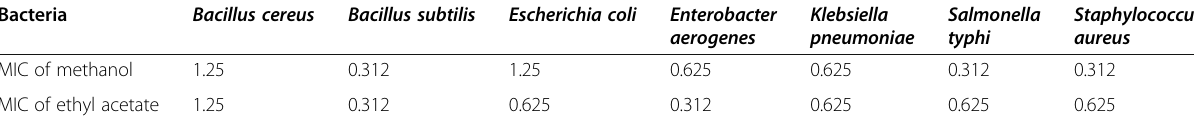
Table 3 MIC of methanol and ethyl acetate extract (mg/mL) of E. cotinifolia against some human pathogenic bacteria Bacteria